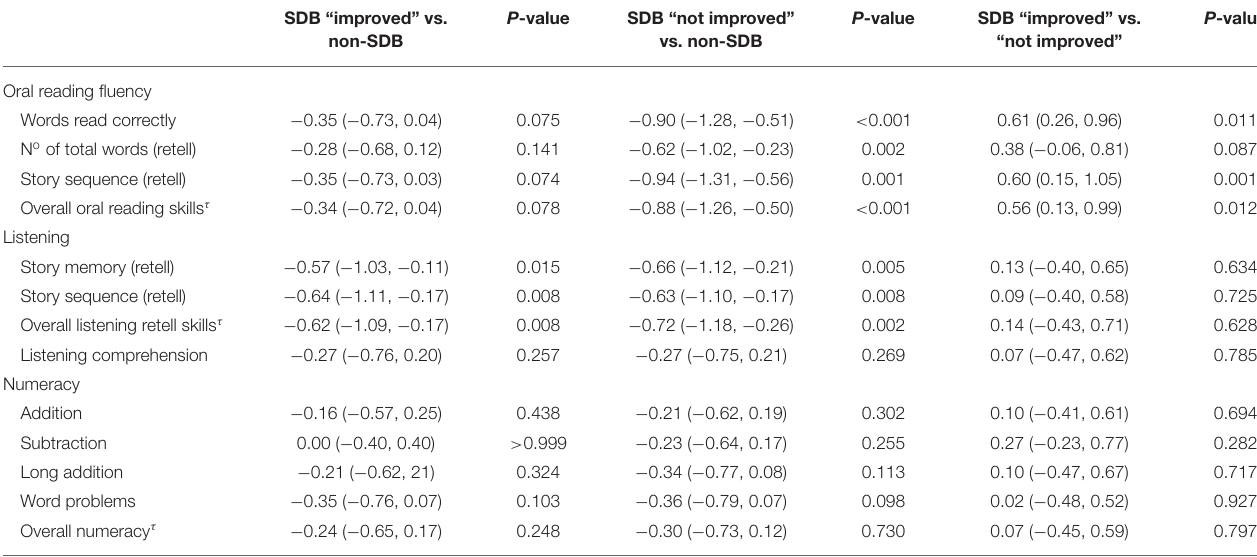
TABLE 3 | Standardized regression coefficients (ßstd) for academic outcomes at age 8 between sleep disordered breathing (SDB) trajectory groups [“improved” ( n = 35) and “not improved” ( n = 42)] and non-SDB children ( n =